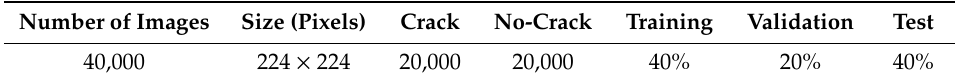
Table 1. Dataset Table 1. Dataset description.